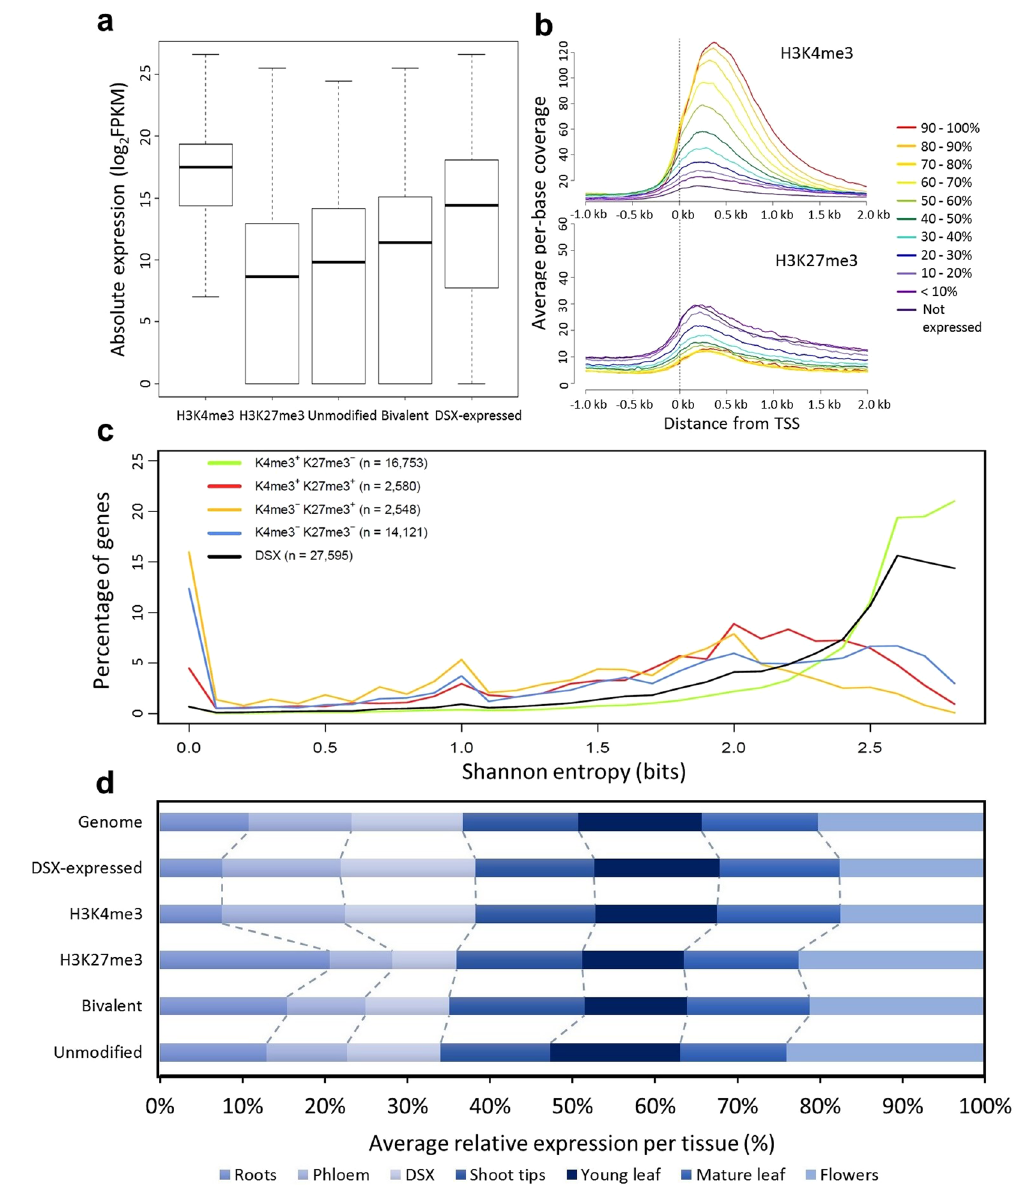
Figure 4. Association of H3K4me3 and H3K27me3 with gene expression levels and specificity. ( a ) Box plot of absolute expression values of genes from different epigenomic categories. The absolute expression profile for developing secondary xylem (far right) is shown for comparison. ( b ) Average per-base coverage of H3K4me3 (top) and H3K27me3 (bottom) ChIP-seq libraries around the transcription start site (TSS) of genes expressed at various levels in developing secondary xylem. ( c ) Tissue-specificity distribution of genes marked by different combinations of H3K4me3 and H3K27me3, as measured by the Shannon entropy index (calculated for genes with nonzero expression in at least one tissue). All pairwise combinations are statistically significant (Kolmogorov-Smirnov test, P < 2.2 × 10 − 16 ). ( d ) Average relative expression of genes in different epigenomic categories in roots, phloem, developing secondary xylem, shoot tips, young leaves, mature leaves and flowers. The relative expression in each tissue of all annotated genes in the genome and genes expressed in developing secondary xylem are shown for comparison. DSX, developing secondary